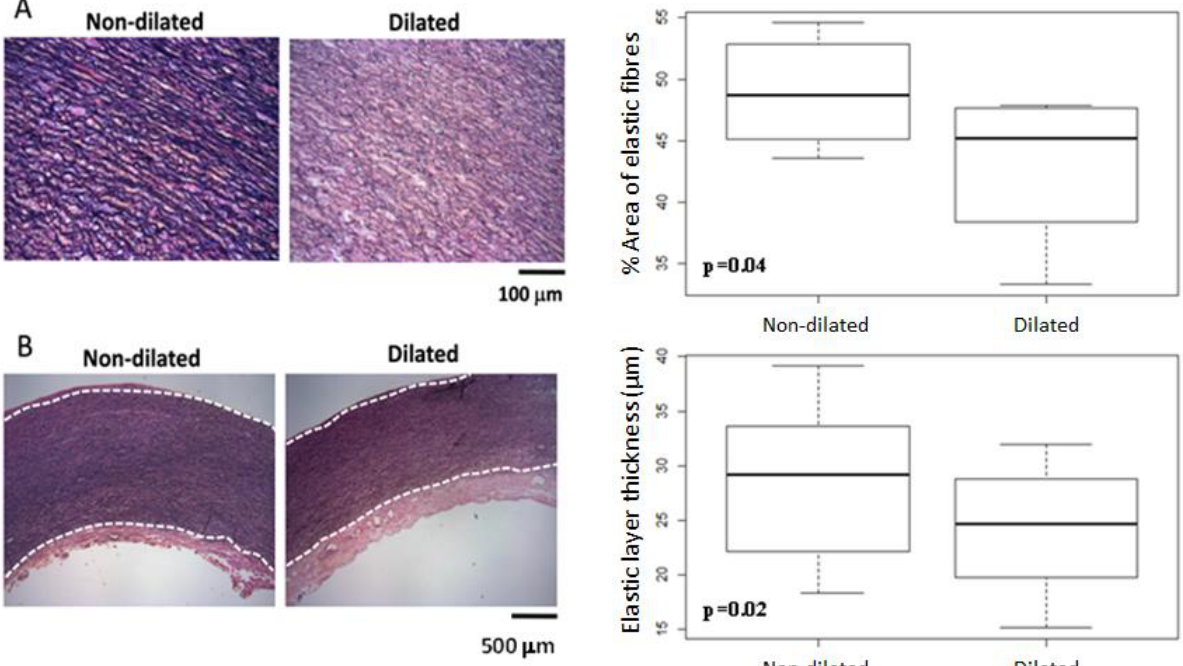
Figure 4. Quantitative histomorphometry of the elastic component. ( A ) Representative images (200× magnification) for non-dilated and dilated segments, and differences (% area) of elastic fibres showing decreased elastic fibres in dilated segments ( p = 0.04); ( B ): example of measurements of elastic layer (40× magnification) and differences in thickness showing a thinner layer in dilated segments ( p = 0.02).